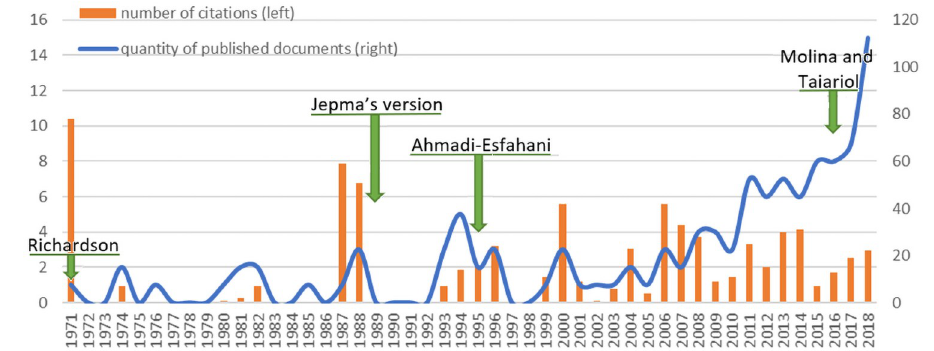
Fig 10. Evolution of scientific production in “Constant Market Share” methodology per year